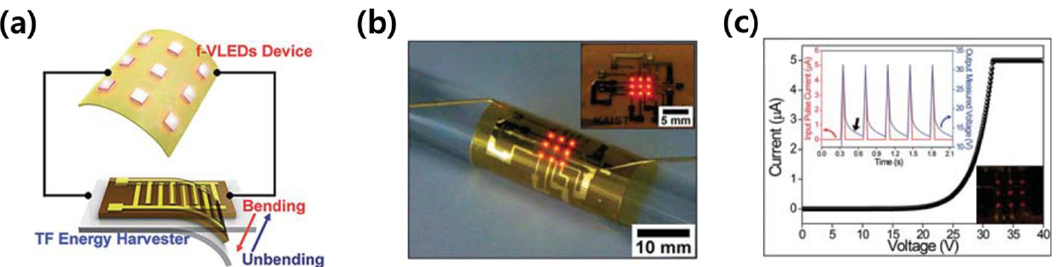
Figure 5. ( a ) Schematic image of self-powered flexible µ LEDs that were composed of flexible red µ LEDs and a thin-film piezoelectric power generator. ( b ) Photograph of flexible red µ LED array. The inset image is a top view of the device. ( c ) I-V curve of flexible µ LED arrays. The top inset shows output current and voltage from a thin-film energy harvester. The bottom inset indicates flexible red µ LEDs, operated by a piezoelectric energy harvester. Reproduced with permission [32]. Copyright 2014, Royal Society of Chemistry.